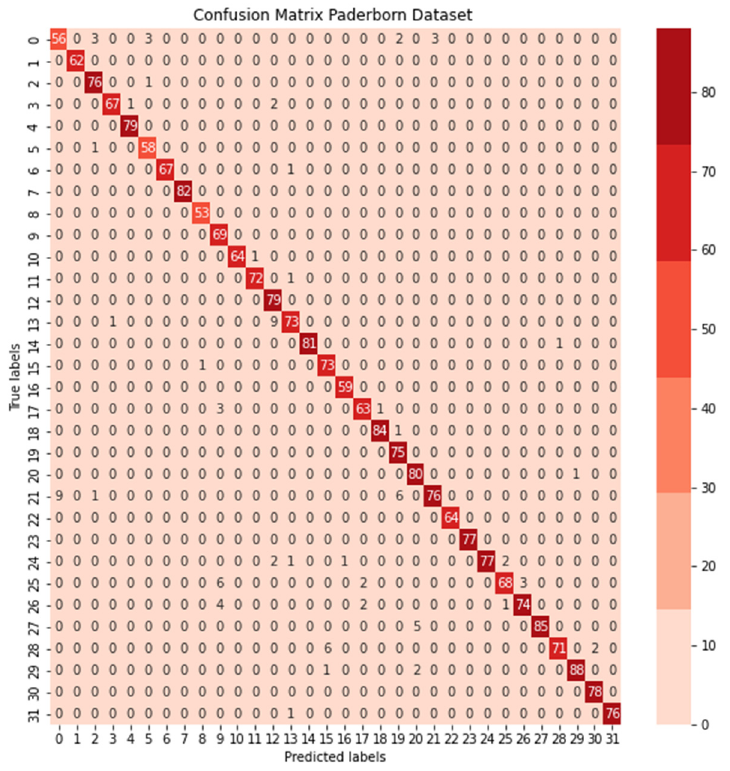
Figure 9. Paderborn dataset with 32-class confusion matrix.